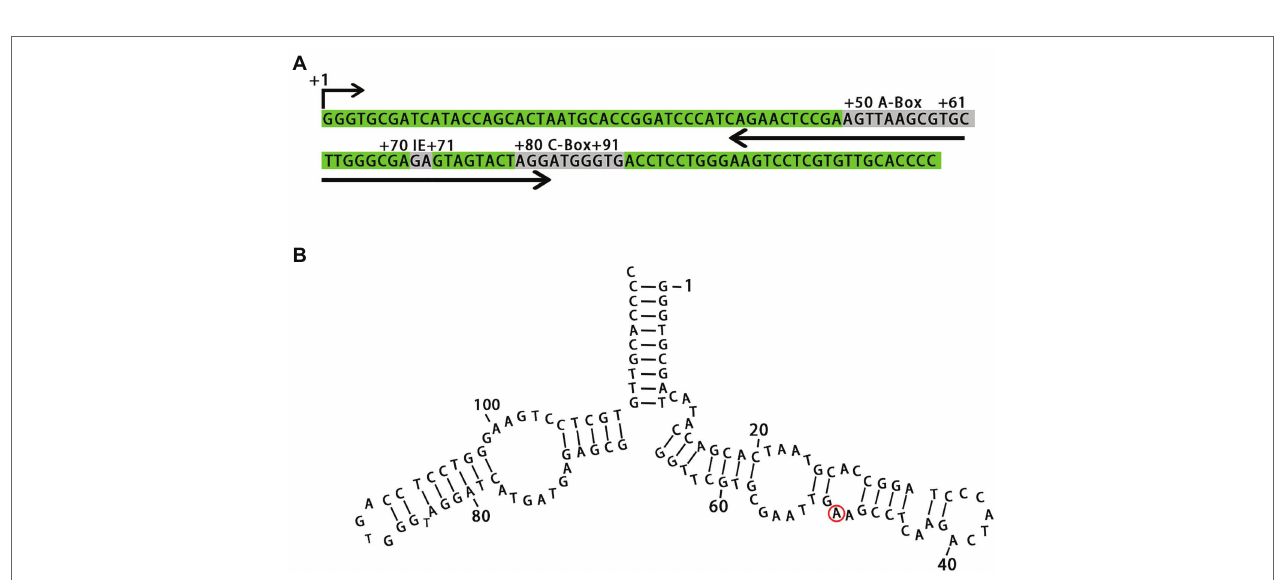
FIGURE 2 | Primary nucleotide sequence of the 5S rDNA gene and secondary structure of the 5S rRNA. (A) Conserved motifs involved in transcriptional regulation are marked as A-box, IE, and C-box. (B) The position of nucleotide substitution specific for clones with short NTS (NB0014-22 and NB0014-23) is marked with a red ring. IE, intermediate